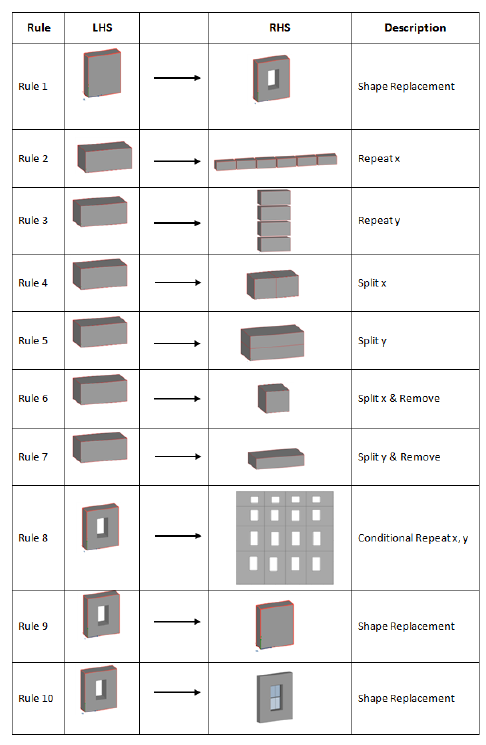
Table 1. Shape Rules {R} for Shape Grammar